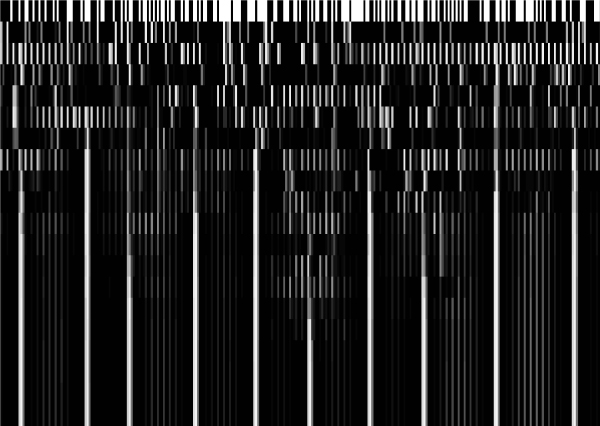
Convergence plot of the network for an array of 100 cells starting from random uniformly distributed binary initial conditions, 0/black or 1/white for ntcA, hetR and patS. Each new row represents the expression levels after one random iteration starting from the state of the previous row. The system converges to one attractor where only some cells differentiate to heterocysts, represented by high values in HetR (the stable vertical lines formed in the figure). The average distance between heterocysts is approximately 10 with a transport factor D = 0.767.